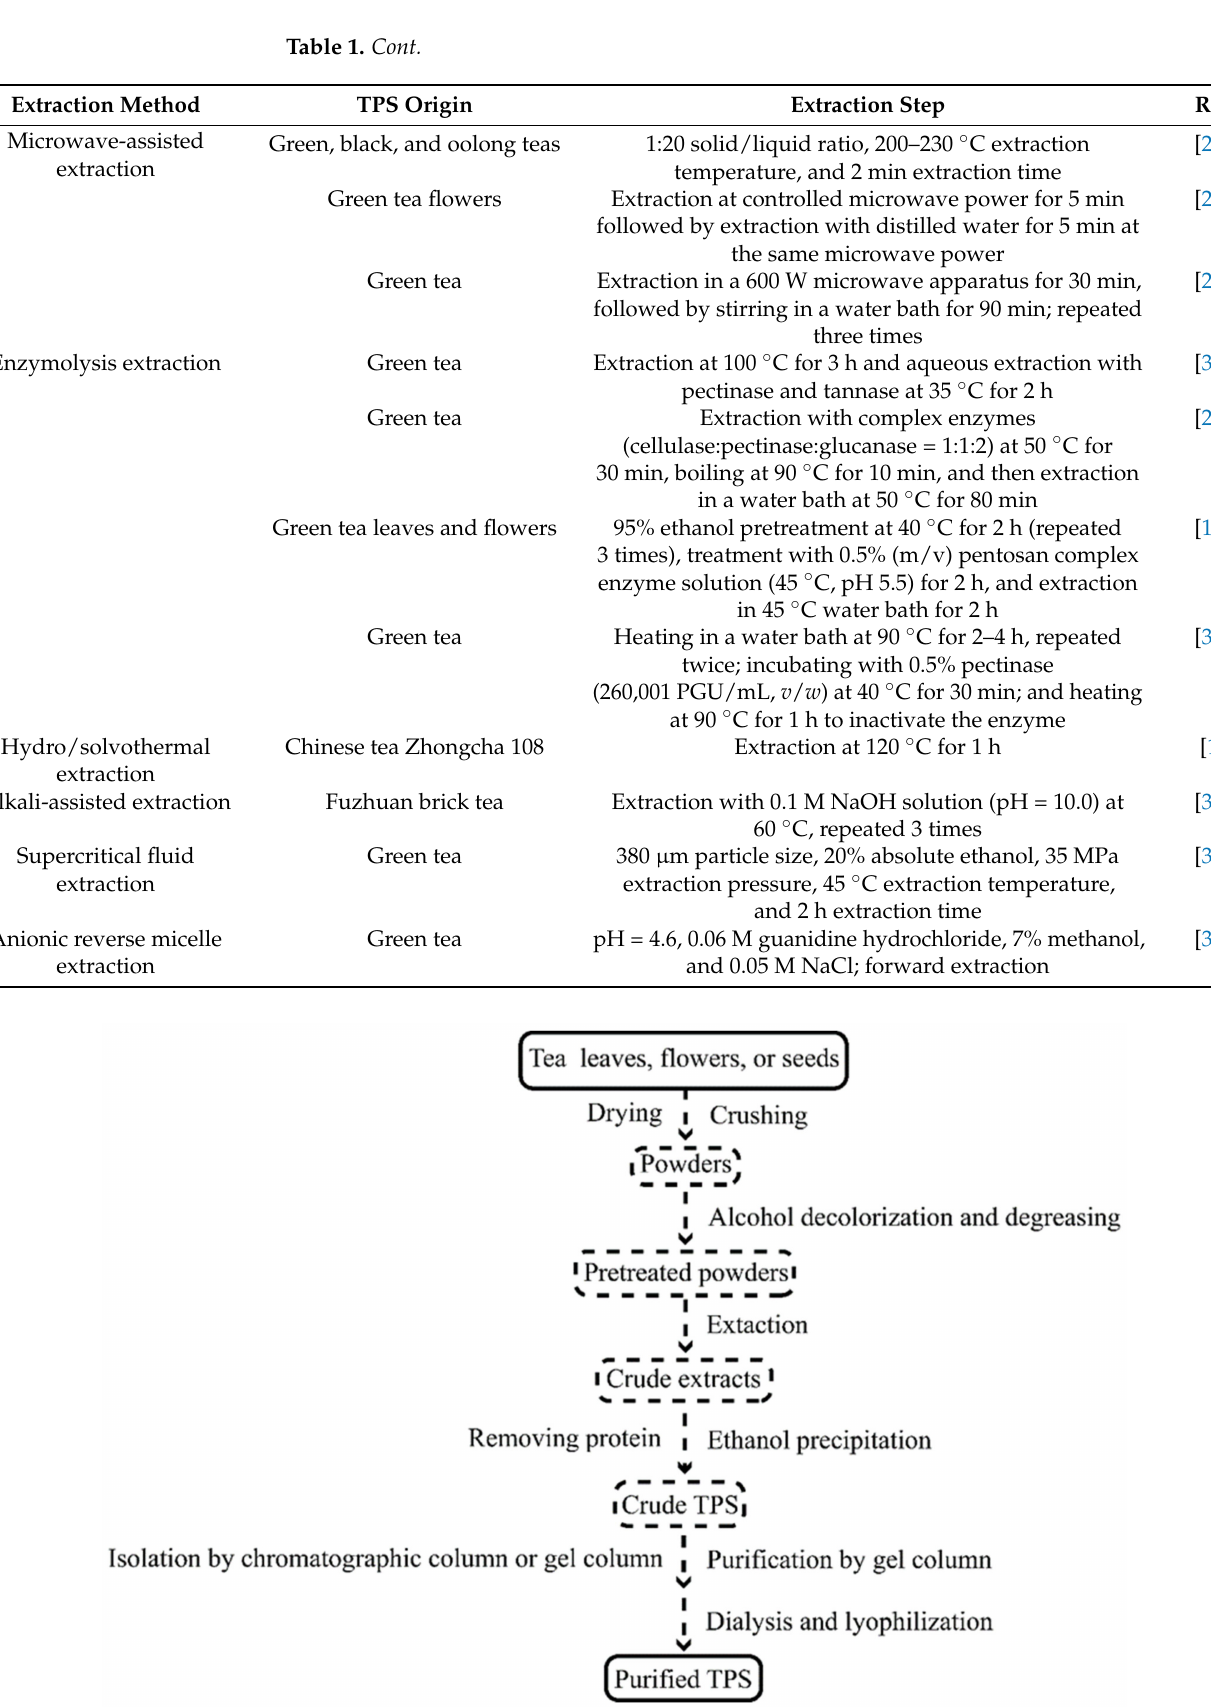
Figure 1. The conventional process of TPS